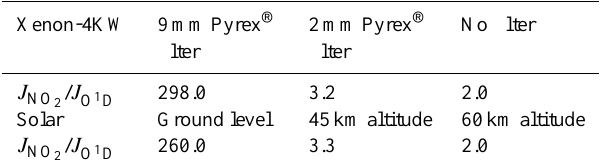
Table 3. J NO / J of xenon lights filtered by different thicknesses O 1 D 2 Pyrex filters determined in the CESAM chamber and of solar light at different altitudes (data taken from TUV/NCAR, 12h, 21 June at the equator).